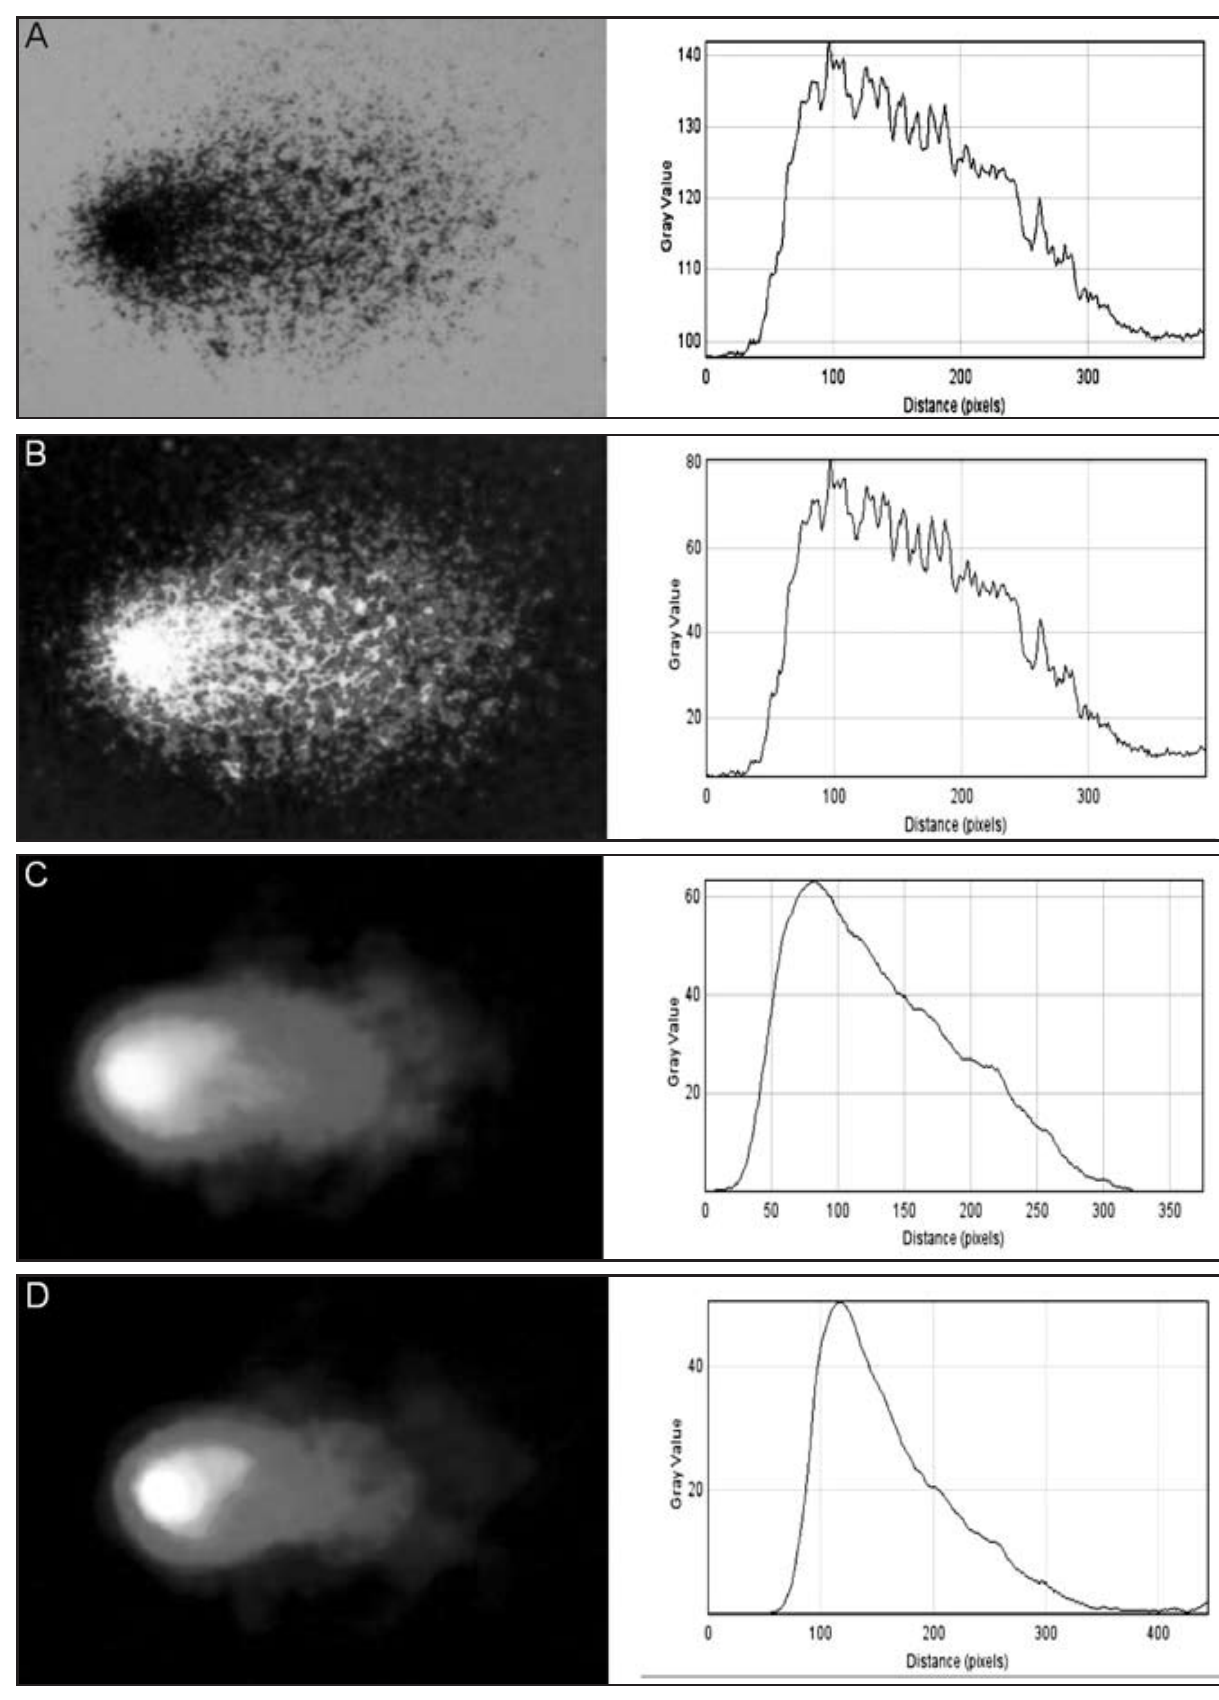
Figura 2 – Fotos do cometa 42 e respectivos histogramas: (A) sem processamento; (B) pré-processamento; (C) algoritmo I; (D) algoritmo